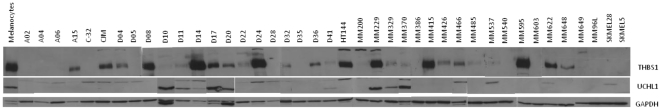
Western blot analysis of THBS1 and UCHL1 protein expression.